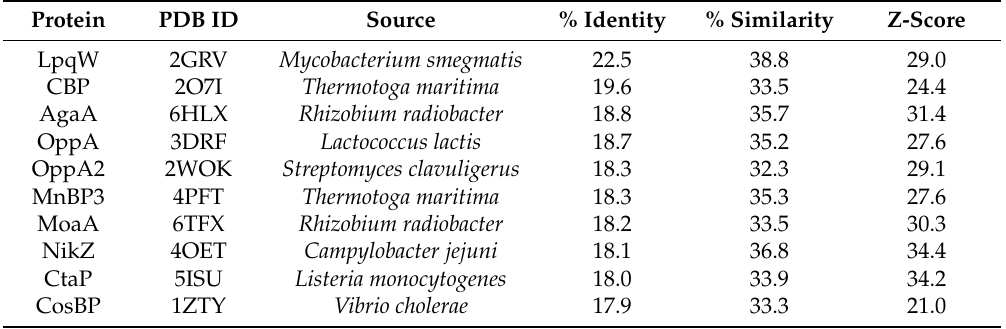
Table 4. EppA homology via position-specific iterative (PSI)-BLAST and comparison to Z-scores.